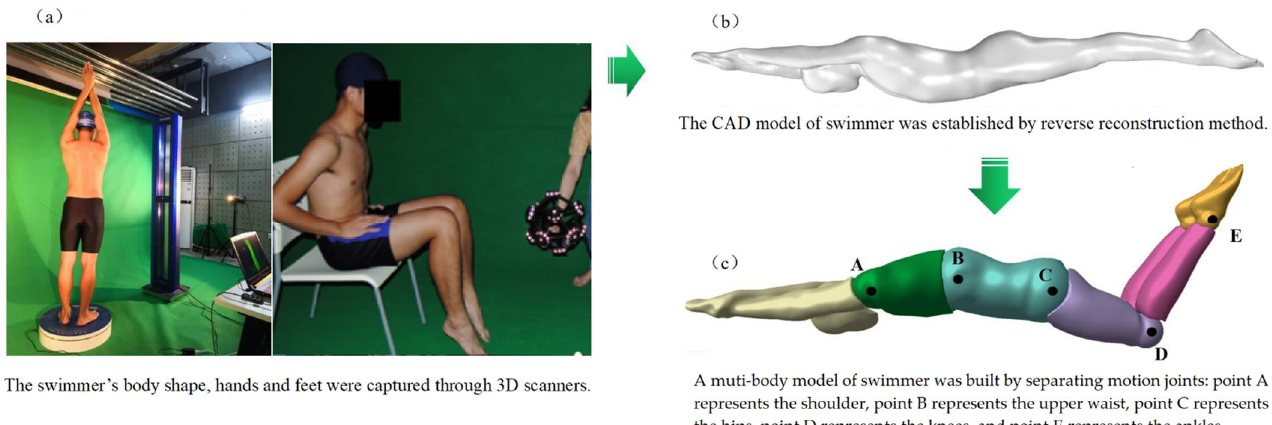
Figure 1. The generation process of the swimmer model. ( a ) The swimmer’s body shape, hands, legs, and feet were captured through 3D scanners; ( b ) The CAD model of swimmer was established by reverse reconstruction method; ( c ) A muti-body model of swimmer was built by separating motion joints: point A represents the shoulder, point B represents the upper waist, point C represents the hips, point D represents the knees, and point E represents the